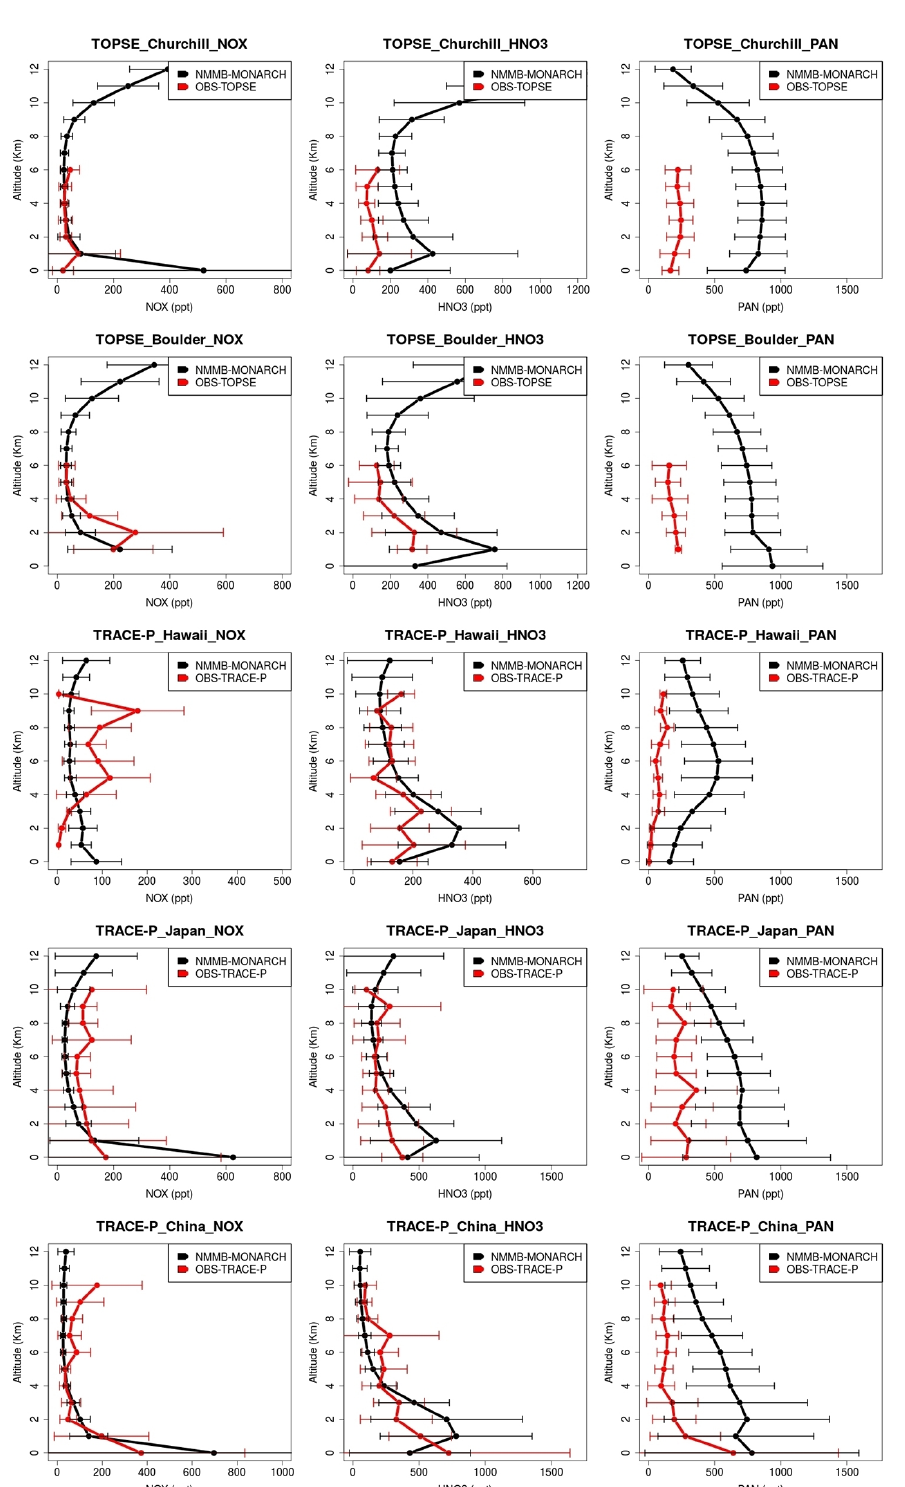
Figure 9. Comparison of modeled (black lines) and observed (red lines) vertical profiles of NO x (first column), HNO 3 (second column) and PAN (third column) for several regions in the US, China, Hawaii and Japan. Horizontal lines show the standard